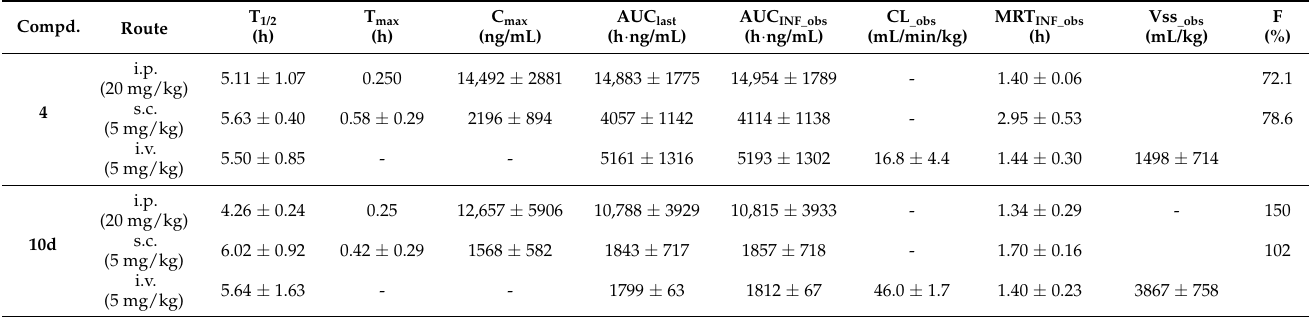
Table 3. Preliminary pharmacokinetic (PK) evaluation of compounds 4 and